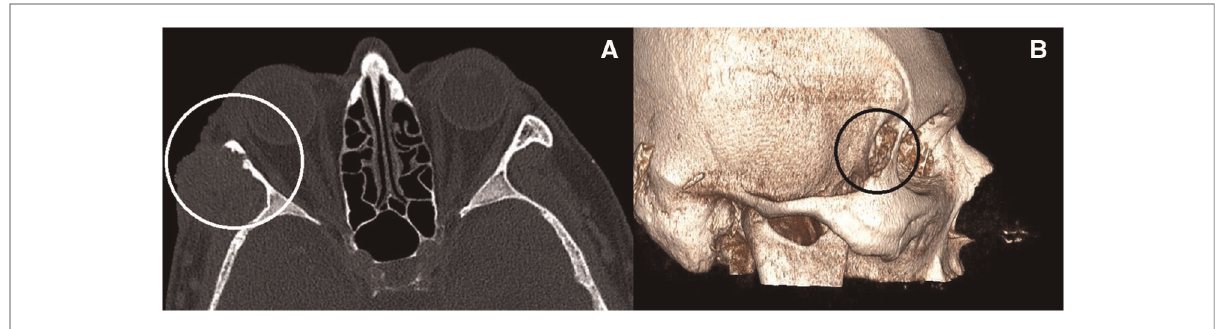
FIGURE 1 ( A,B ) Orbital CT scan — tumor eroding the